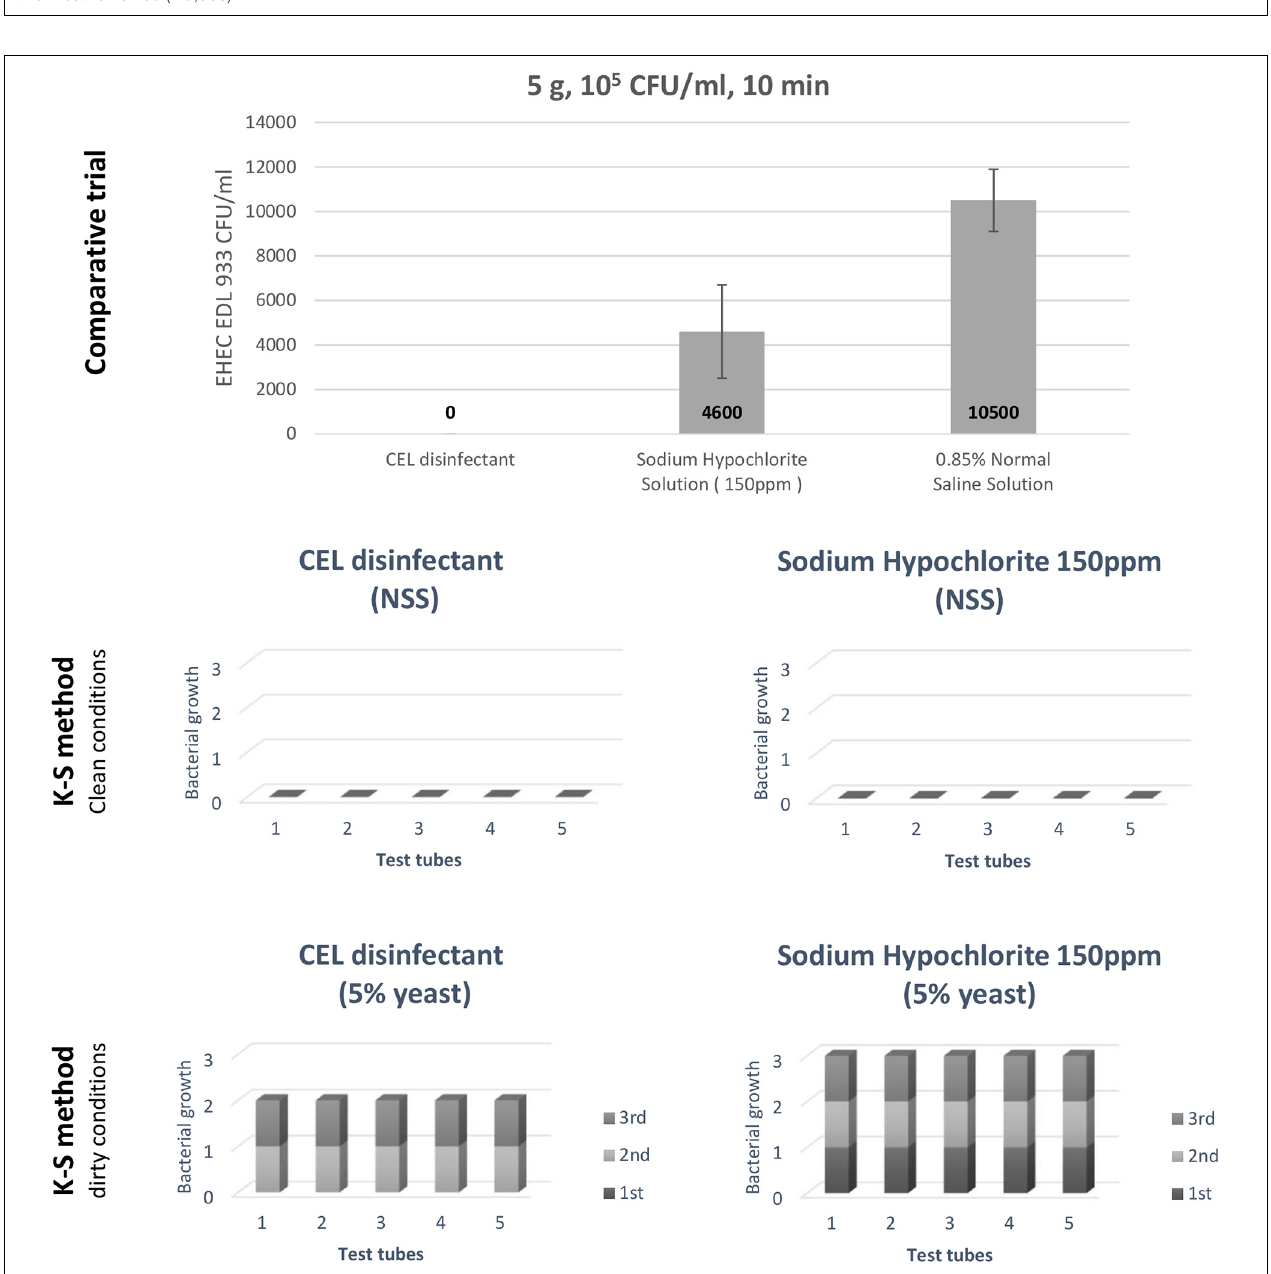
FIGURE 3 | A comparative trial to assess the calcium hydroxide–ethanol–lactate (CEL) disinfectant, and an evaluation of the CEL disinfectant by Kelsey–Sykes (K-S) method (against EHEC Escherichia coli O157:H7 EDL933).